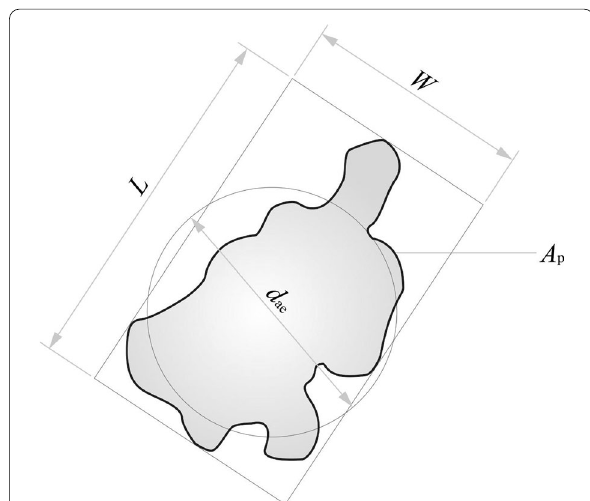
Fig. 3 The area, area-equivalent diameter, length and width of a particle